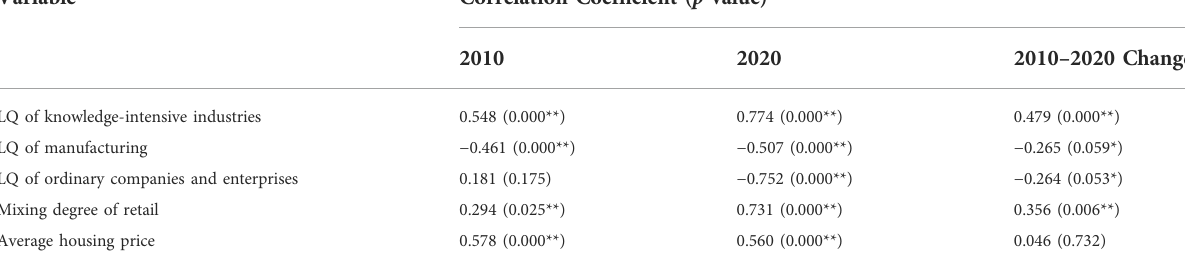
TABLE 4 Spearman correlations for 2000, 2010, and 2000 – 2010 change against the commercial gentri fi cation index in Chengdu ( N = 58).